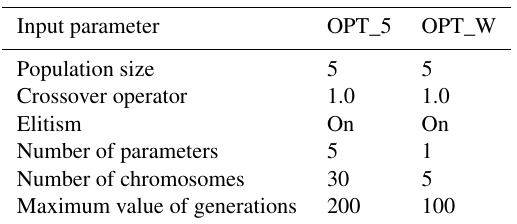
Table 2. The input parameters for micro-GA in experiments OPT_5 and